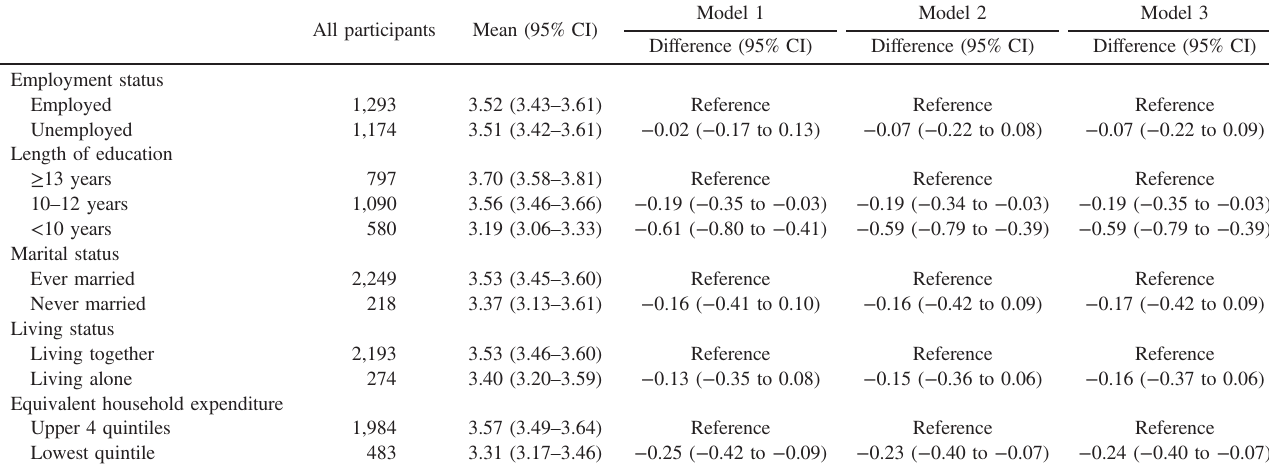
Table 4. Average number of correct answers on cardiovascular risk factors and di ff erences: NIPPON